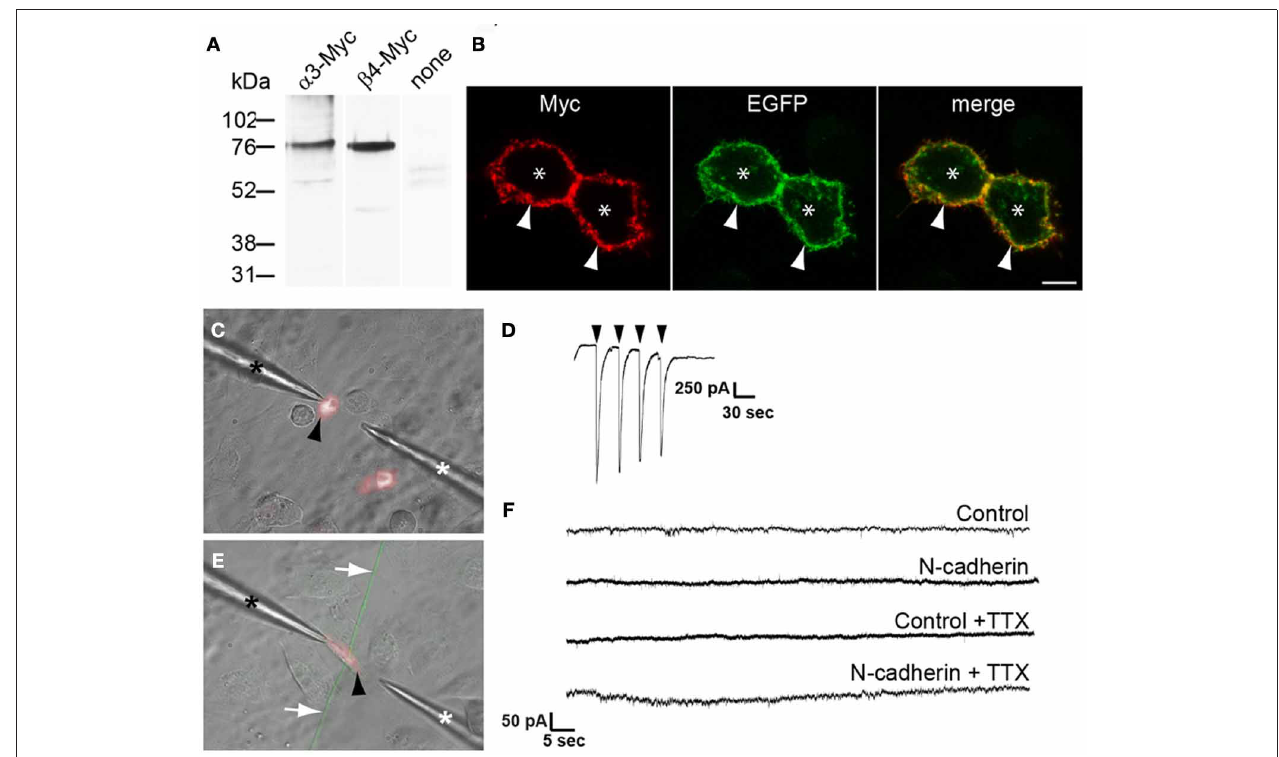
FIGURE 3 | Electrophysiological analysis of the effect of N-cadherin on α 3 β 4 nAChR response in transfected CHO cells in contact with cholinergic axons from brainstem nuclei explants. (A) Immunoblot detection with anti Myc-tag antibodies of nAChR subunit expression in cell lysates of CHO cells transfected with α 3-Myc, β 4-Myc, or untransfected (none). A band of ∼ 76kDa was detected with both nAChR subunits. (B) Confocal images across the center of CHO cells cotransfected with α 3-Myc, β 4-Myc, and membrane-bound myristoylated EGFP (green), and immunostained with anti Myc-tag antibodies and Cy3-conjugated secondary antibodies (red). Asterisks indicate CHO cell bodies and arrows point to the cell membrane. (C) Microphotograph of cultured CHO cells transfected with TagRFP-T and α 3 β 4nAChR subunits (black arrowhead) in the recording chamber. One pipette was used for patch-clamp recording (black asterisk) and a second pipette was used to deliver acetylcholine (white asterisk). (D) Voltage-clamp recording of a CHO cell transfected with α 3 β 4nAChR subunits and TagRFP-T, and exposed to a solution of